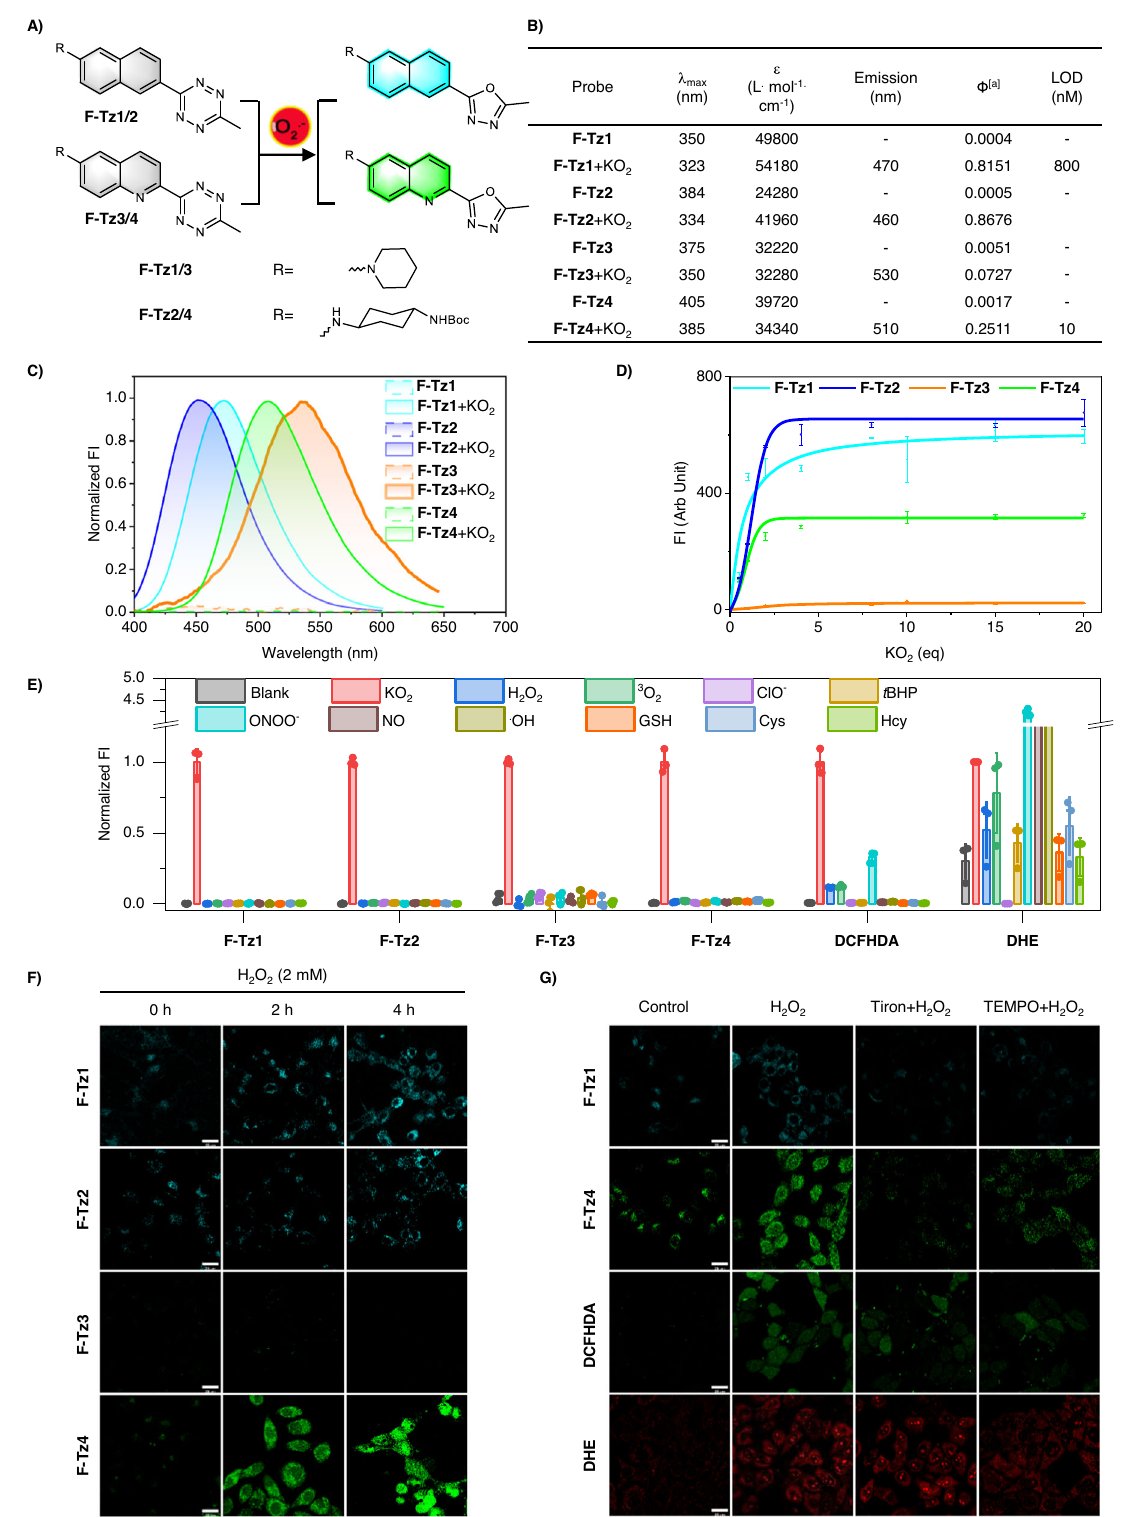
fi rst chose naphthalene and quinoline (Fig. 2A). These two fl uor- ophores are structurally similar but emit in different spectra